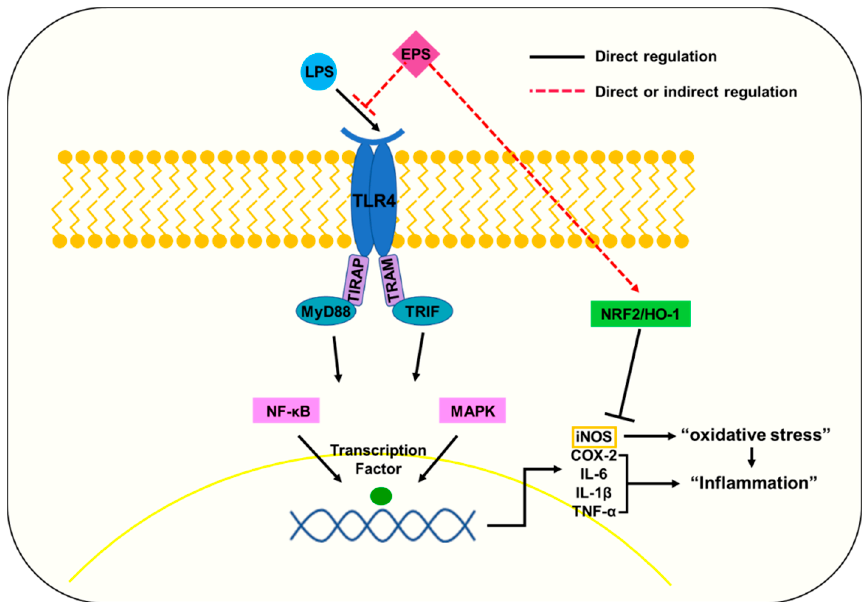
Figure 8. When LPS binds to TLR4 in the cell membrane, the resulting complex can lead to the activation of adaptor proteins including MyD88 and TIR-domain-containing adapter-inducing interferon- β (TRIF). NF- κ B is phosphorylated and translocated into the nucleus by adaptor proteins. MyD88 and TRIF phosphorylate members of the MAPK pathway, and the MAPK family protein translocates transcription factors related to the inflammatory response into the nucleus. These translocated factors upregulate the expression of proinflammatory cytokines and COX-2. However, EPS could inhibit the LPS-induced inflammatory response by downregulating TLR4. EPS also repressed the expression of iNOS, which led to oxidative stress by upregulating the NRF2/HO-1 pathways. Nevertheless, more research is required to elucidate how EPS regulates the expression of TLR4.